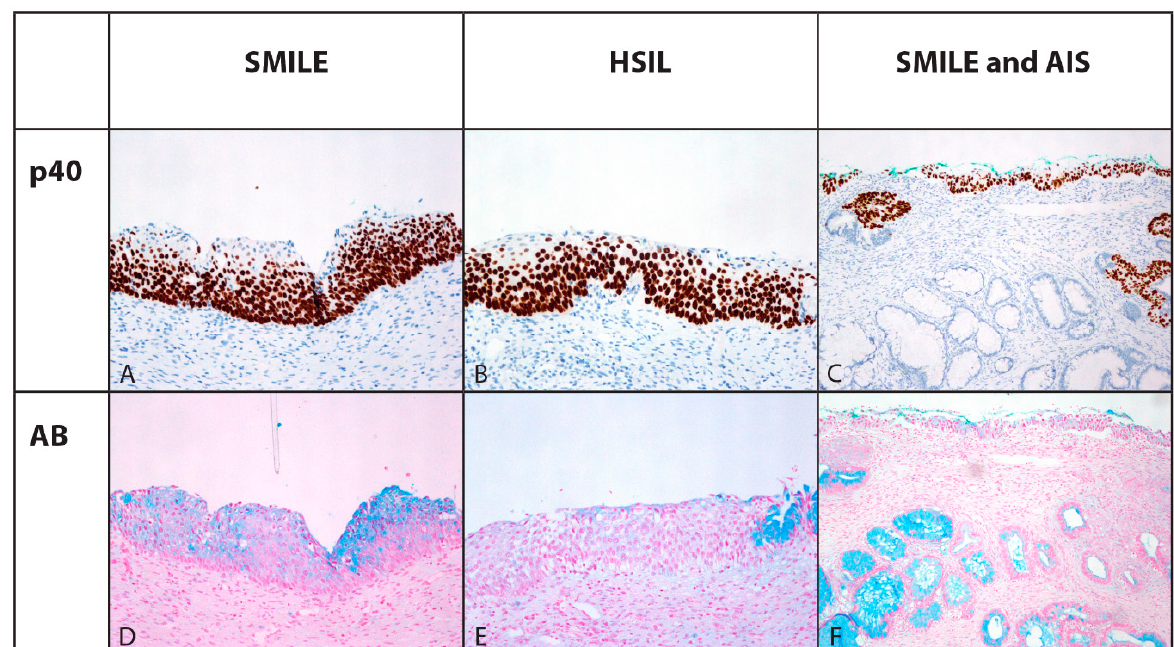
Figure 2. Immunohistochemical expression of biomarker p40 in lower two-thirds ( A ) and presence of mucin by Alcian blue staining throughout the full thickness ( D ) of stratified mucin-producing intraepithelial lesion ( × 200). Similar expression of p40 in adjacent high-grade squamous intraepithelial lesion ( B ) with some mucin in the remaining overlaying endocervical epithelial cells focally ( E ). Predominant lack of p40 expression ( C ) and presence of mucin ( F ) in endocervical adenocarcinoma in situ; however, focal p40 positivity can be seen in the epithelial islands in the upper right and left quadrant of the specimen, and p40 positivity and scattered mucin vacuoles can be seen in the remnants of the SMILE in the surface epithelium.